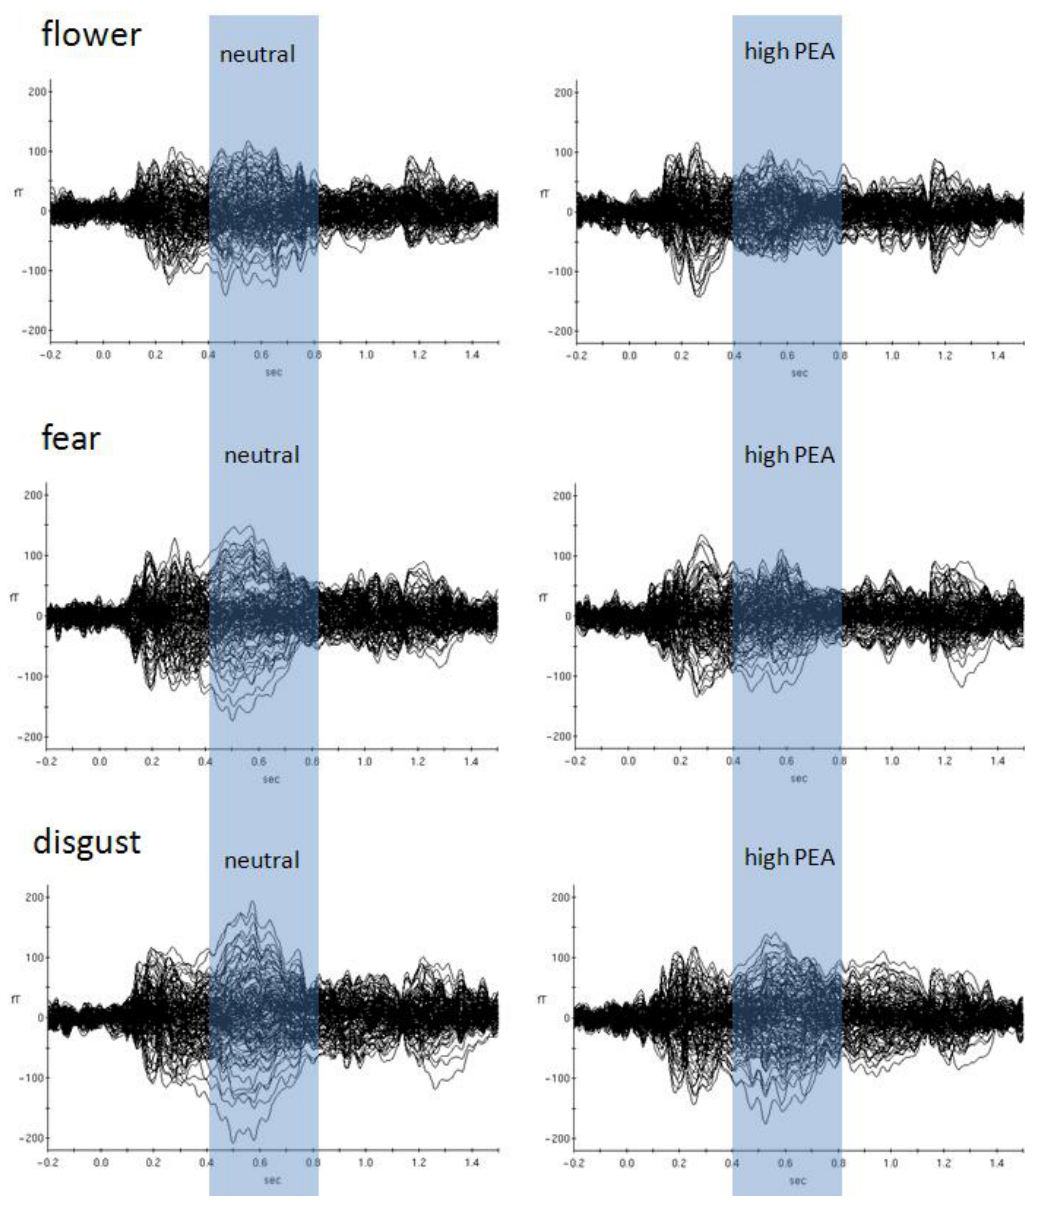
Figure 3. Comparison of MEG curves reflecting olfactory control during picture processing versus high concentration positive odour during picture processing for